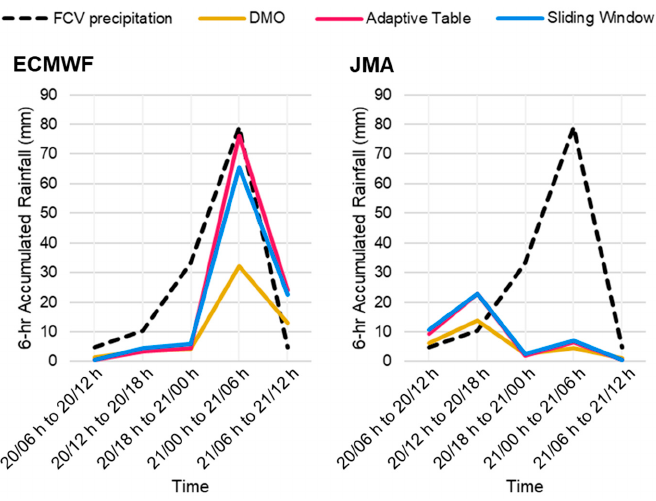
Figure 19. T + 12 6 h FCV rainfall (as the observed truth), the DMO rainfall of ECMWF/JMA and those with frequency-matching methods applied, for 20–21 May 2016.